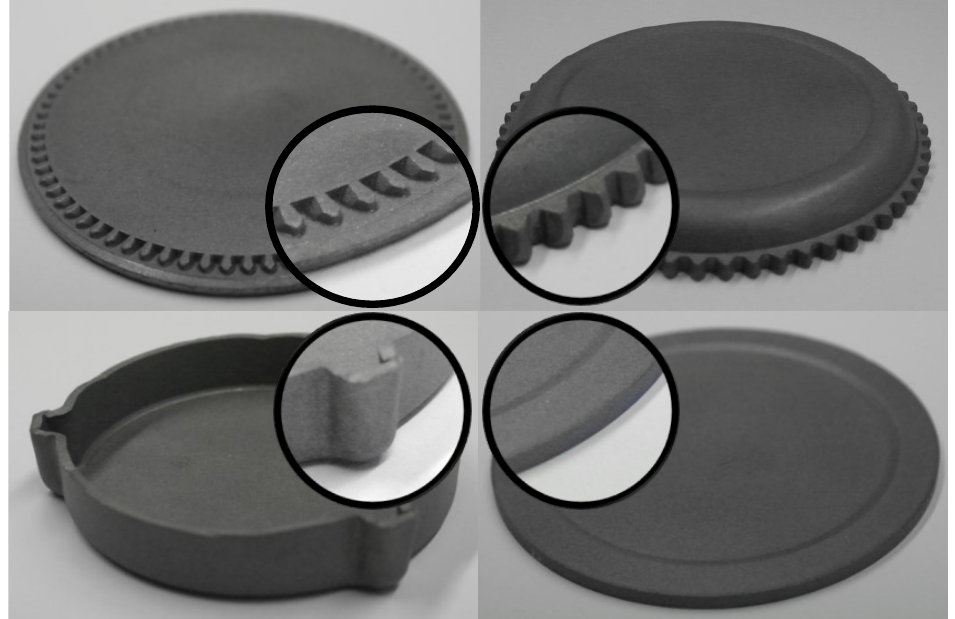
Figure 2. Typical SBMF parts from test productions and different magnified secondary design features (SDF). The diameter is about 80mm, the sheet thickness is 2mm and the material is DC04